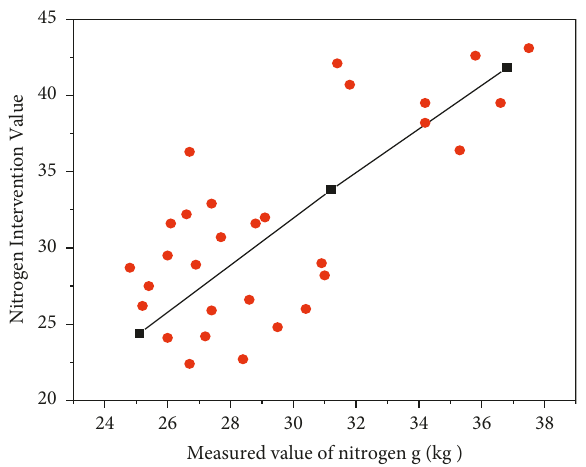
Figure 4: Verification results of vegetation index combined with SMLR nitrogen prediction